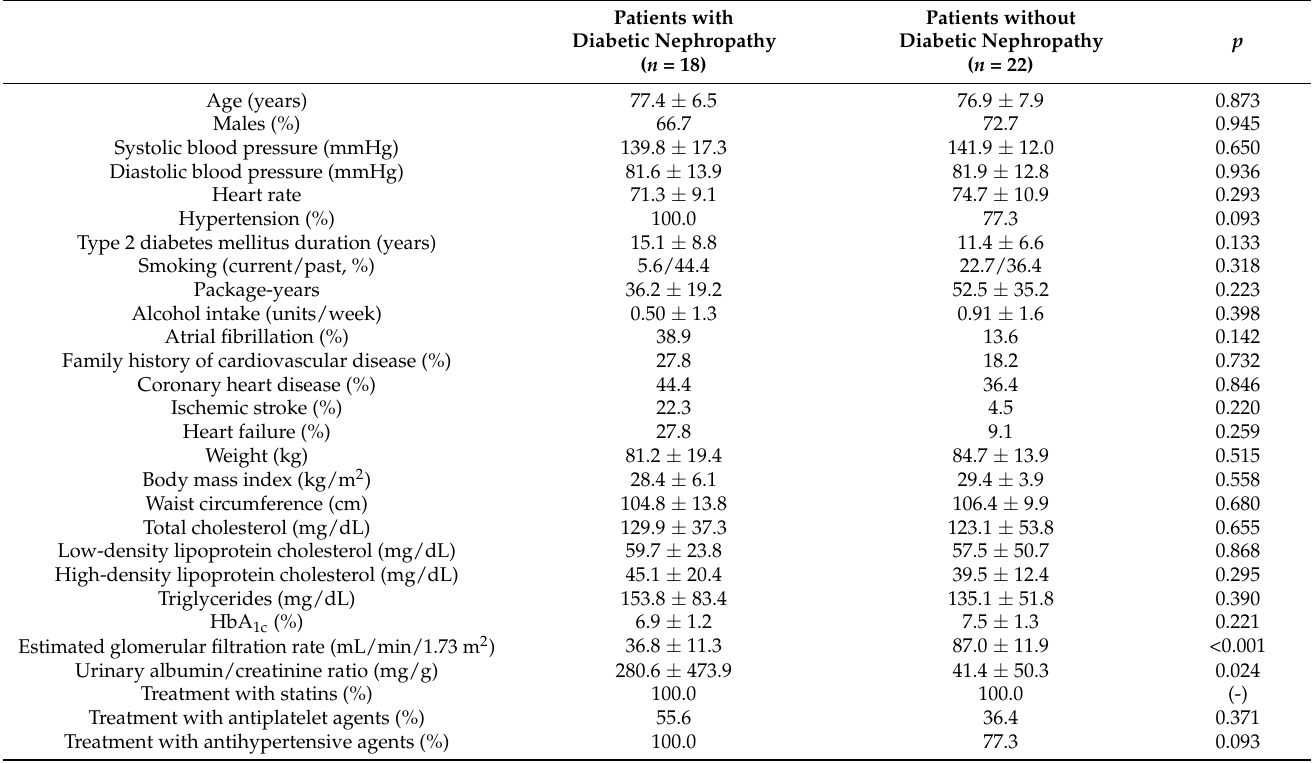
Table 1. Characteristics of patients with diabetic nephropathy and of patients without diabetic nephropathy (data shown are percentages or mean ± SD). Patients with Diabetic